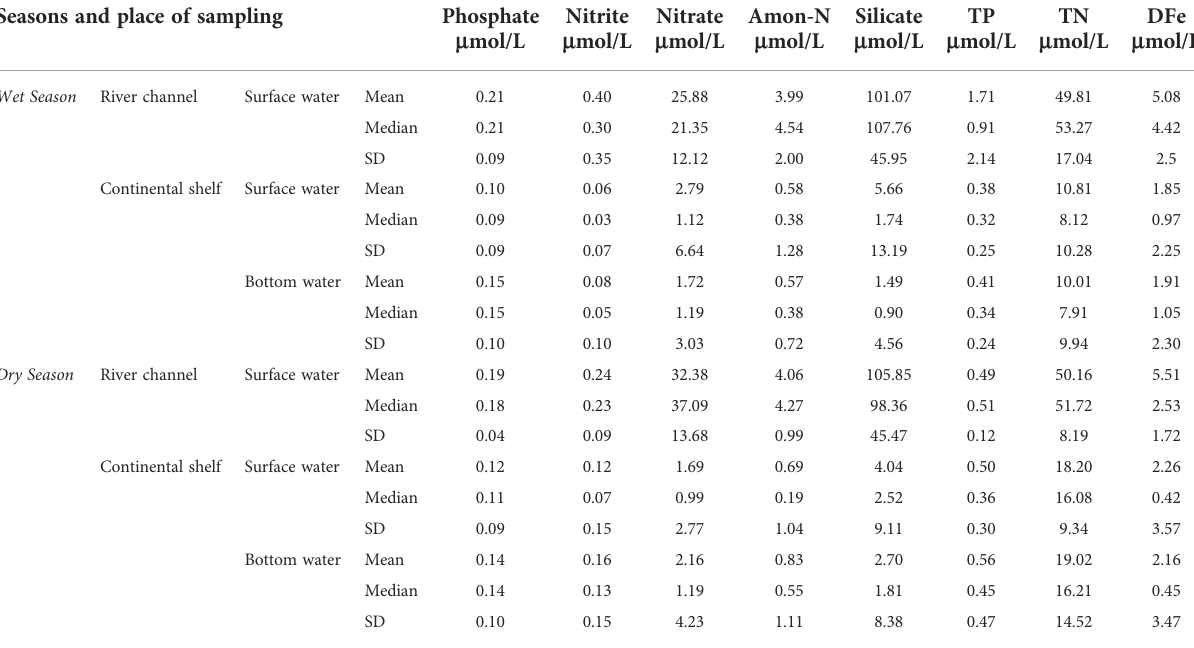
TABLE 2 Dissolved major (phosphate, nitrite, nitrate, ammoniacal nitrogen – Amon-N - and silicate) and micronutrient (dissolved iron - DFe) mean, median and standard deviation (SD) values in the Doce river channel and the continental shelf adjacent to the Doce River mouth. MAJOR AND MICRO (DFe) NUTRIENTS CONCENTRATIONS Seasons and place of